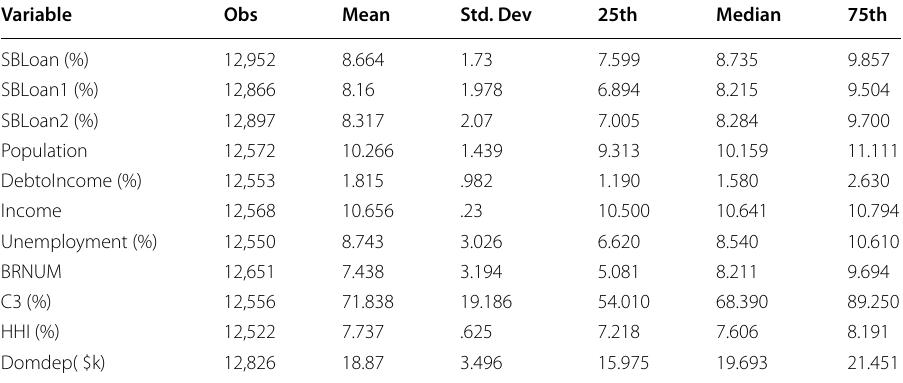
Table 3 Descriptive statistics of county